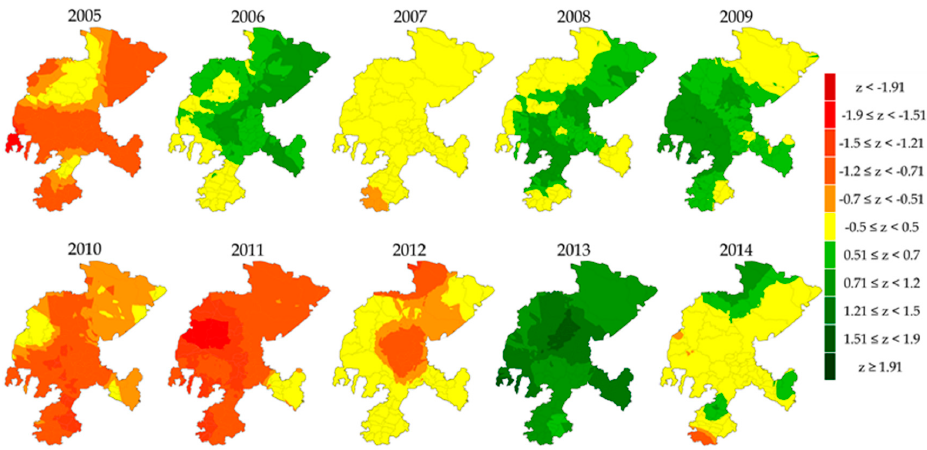
Figure A5. Twelve ‐ month timescale Standard Precipitation Index (April–March).